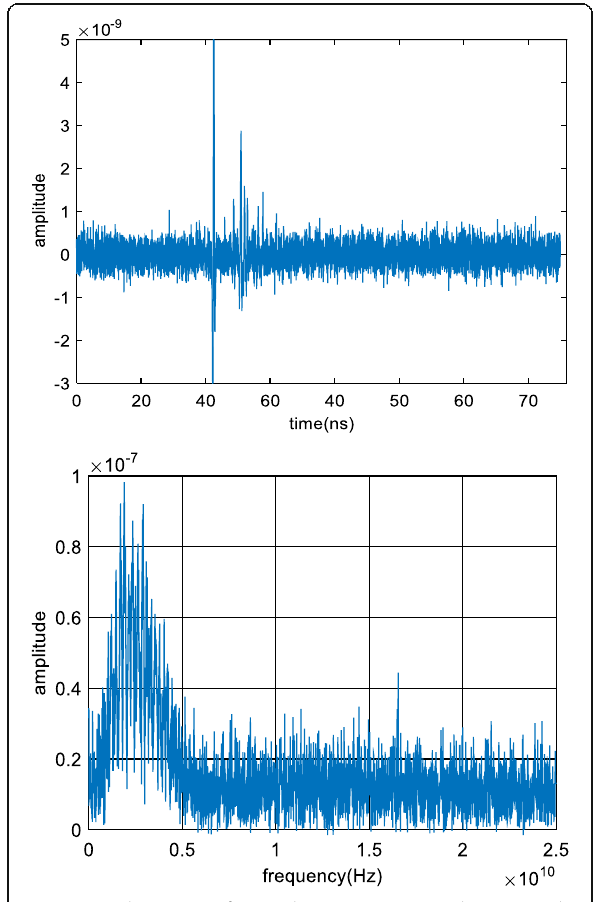
Fig. 5 Time domain waveform and energy spectrum with E b / N 0 =35 dB